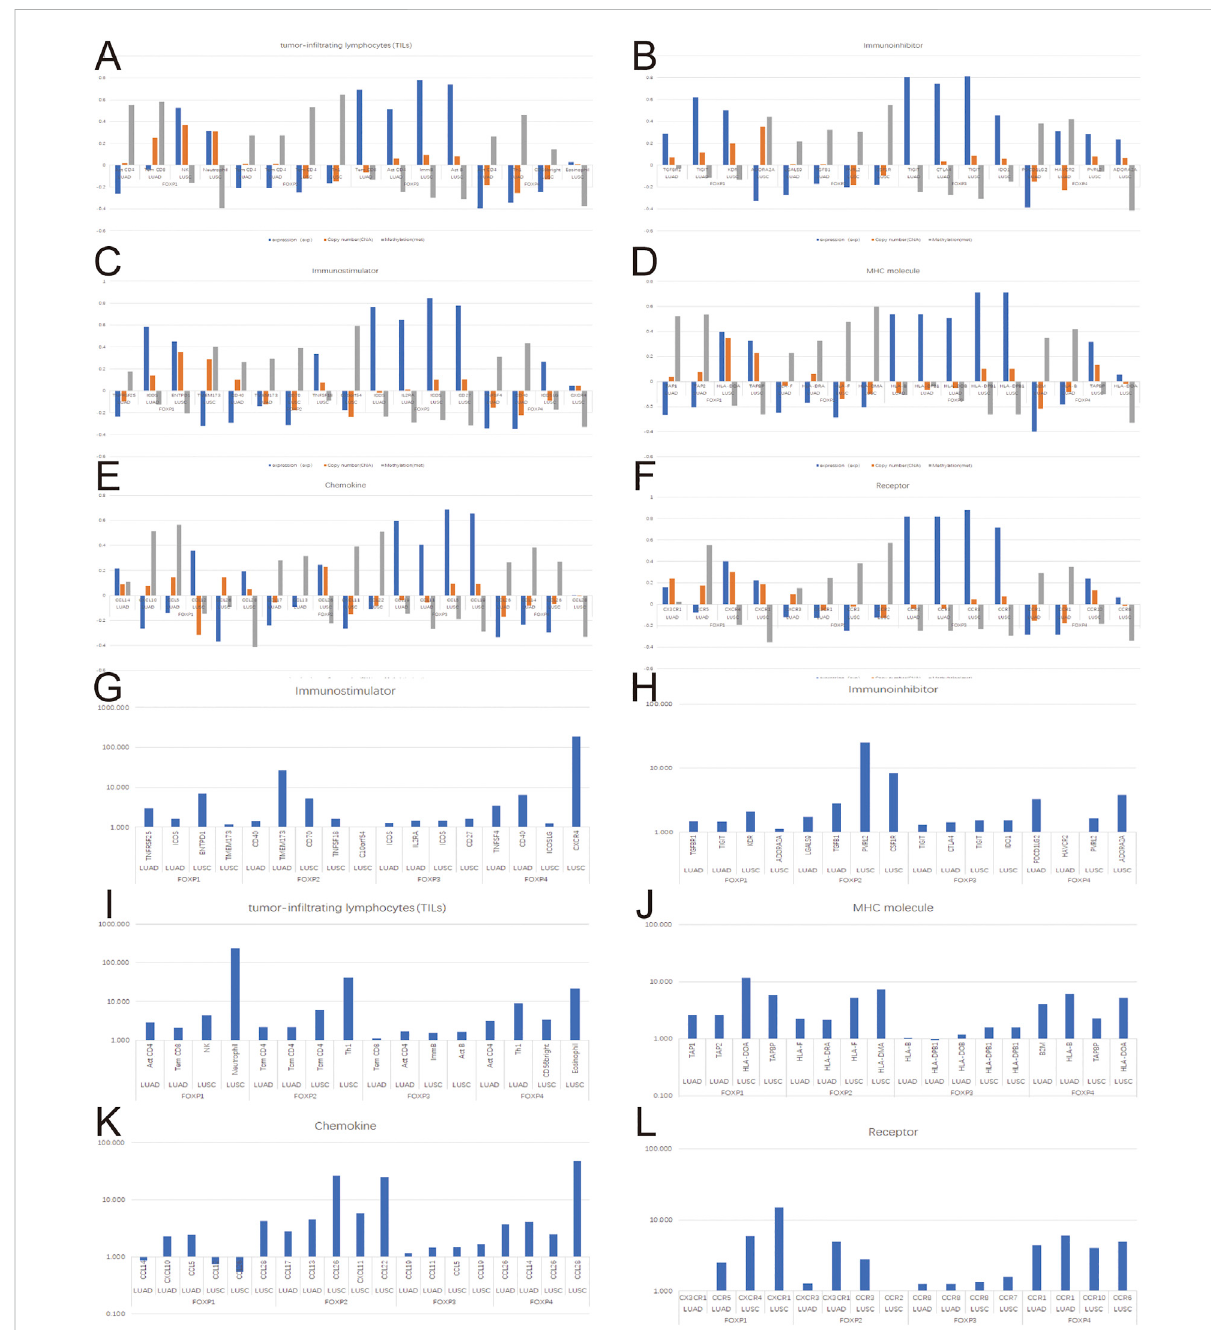
FIGURE 11 The effects of FOXP family expression, copy number alteration, and DNA methylation on immune factors. (A – F) These histograms present the correlation scores of the top two most relevant immune in fi ltration module and correlation scores modi fi ed by copy number alteration and DNA methylation. (G – L) These histograms present the fold relationship between copy number alteration and DNA methylation correlation scores of the FOXP family in NSCLC. (CNA, Copy number alteration; MET, DNA